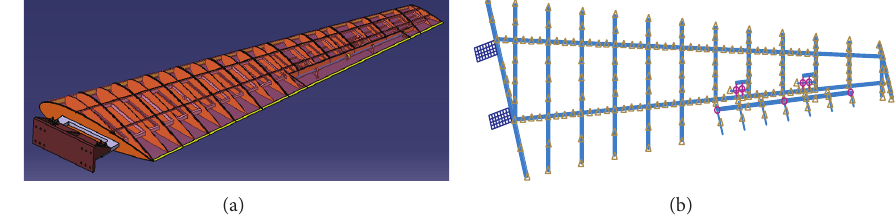
Figure 1: Structure and its finite element model for a wing.